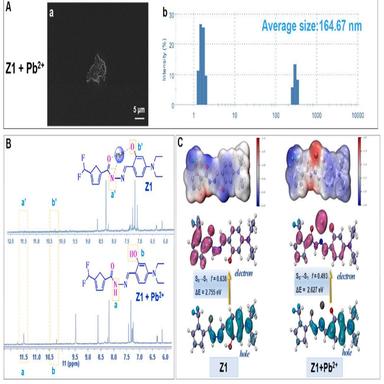
Mechanism verification of probe recognition of Pb2+. A. (a) Scanning electron microscope (SEM) morphologies of Z1 + Pb2+. (b) Particle size distribution of Z1 + Pb2+. B⋅ 1 H NMR titration experiment of Pb2+. C. DFT calculations of Z1 and Z1 + Pb2+.